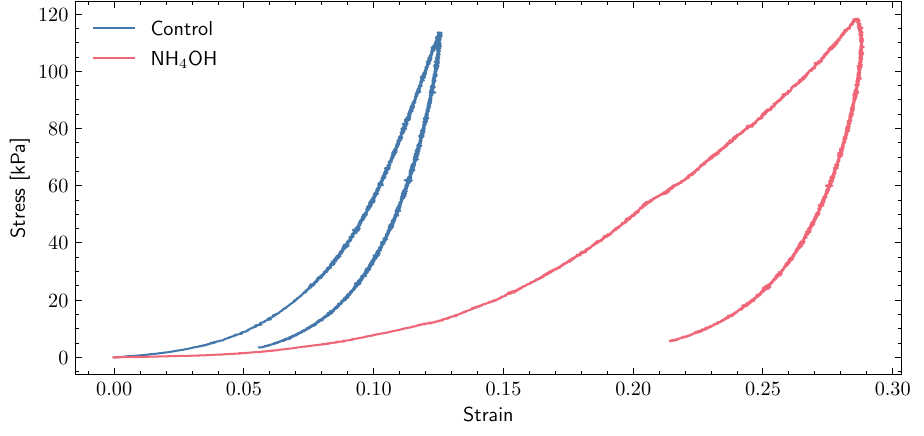
Figure 5. Typical load/unload curves for control and NH 4 OH samples. Hysteresis is more pronounced after chemical treatment. The limit force was 2 N.